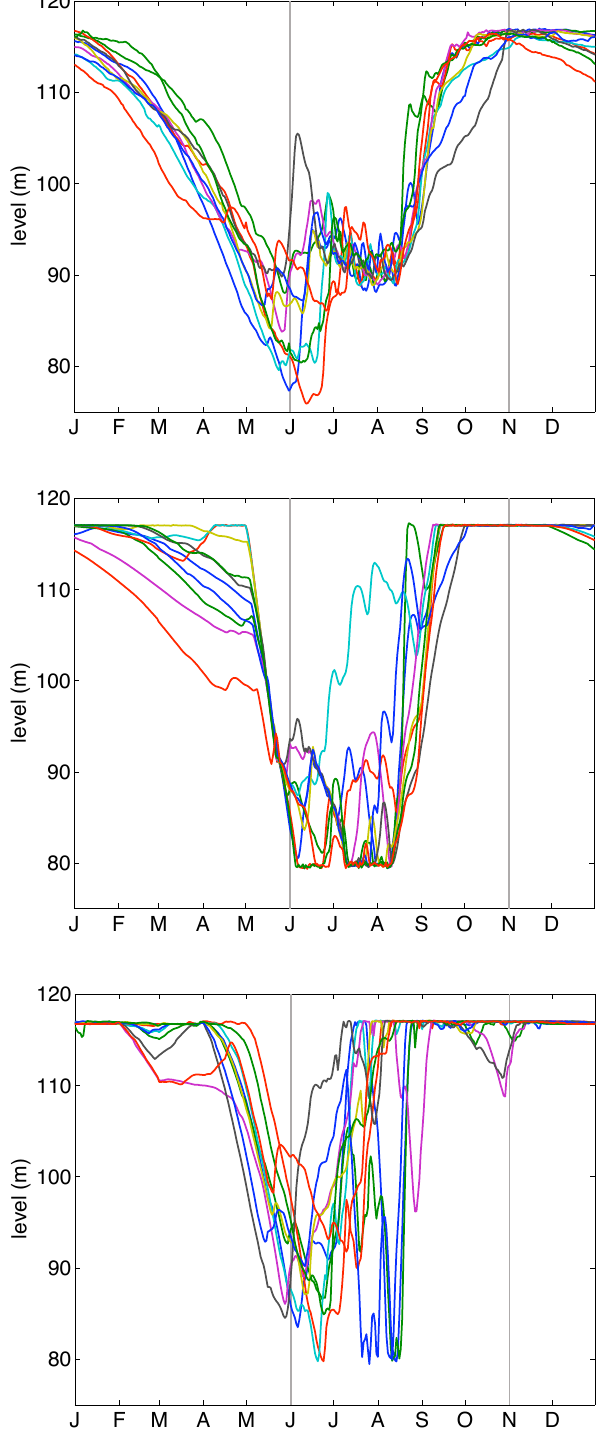
Fig. 3. Yearly pattern of the HoaBinh level with historical operation (top panel), MOGA-19 policy (middle panel) and DDP-21 (bottom panel) over the evaluation horizon